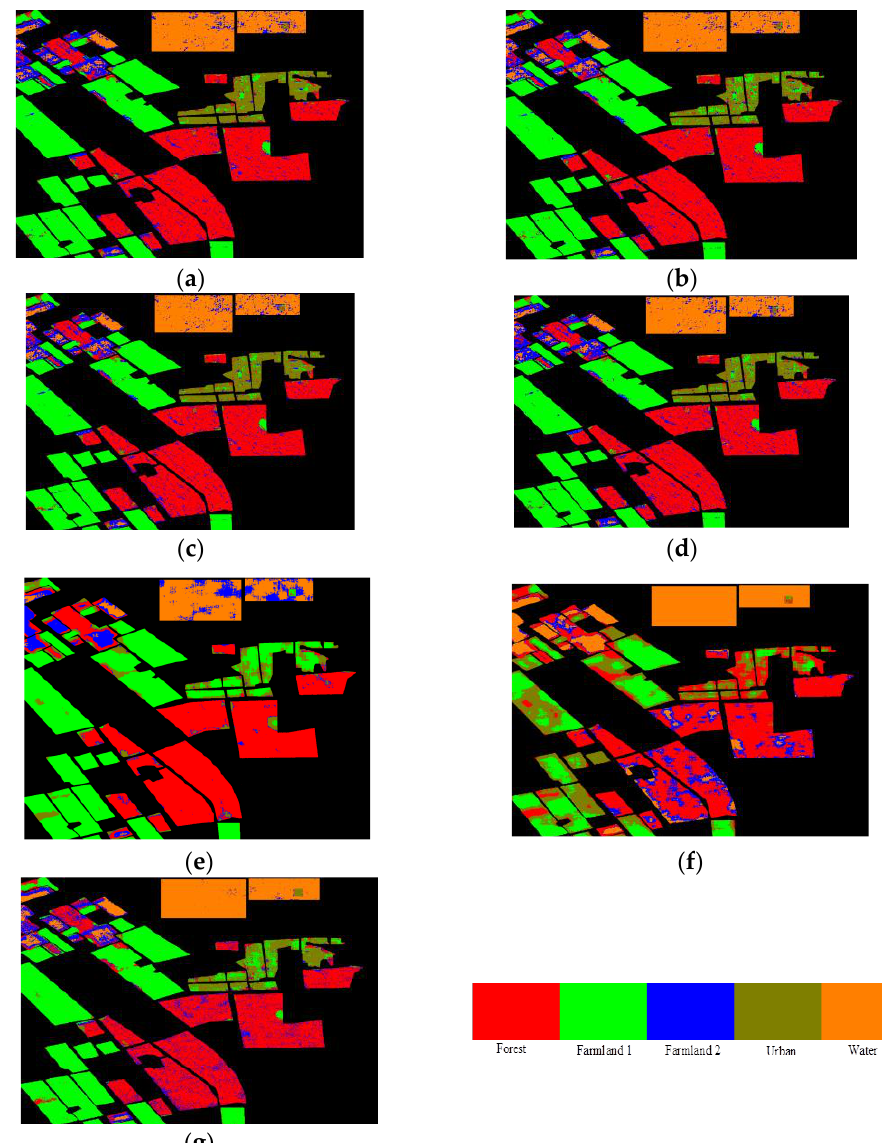
Figure 14. The confusion matrices of ( a ) GCA-CNN, ( b ) GHFM-CNN and the ( c ) OI-CNN.